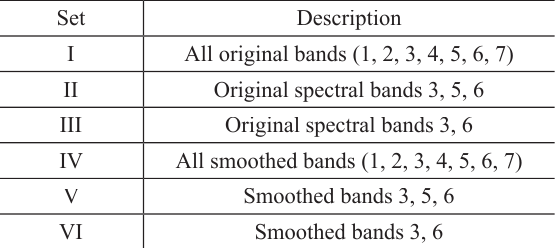
Input data combination to the